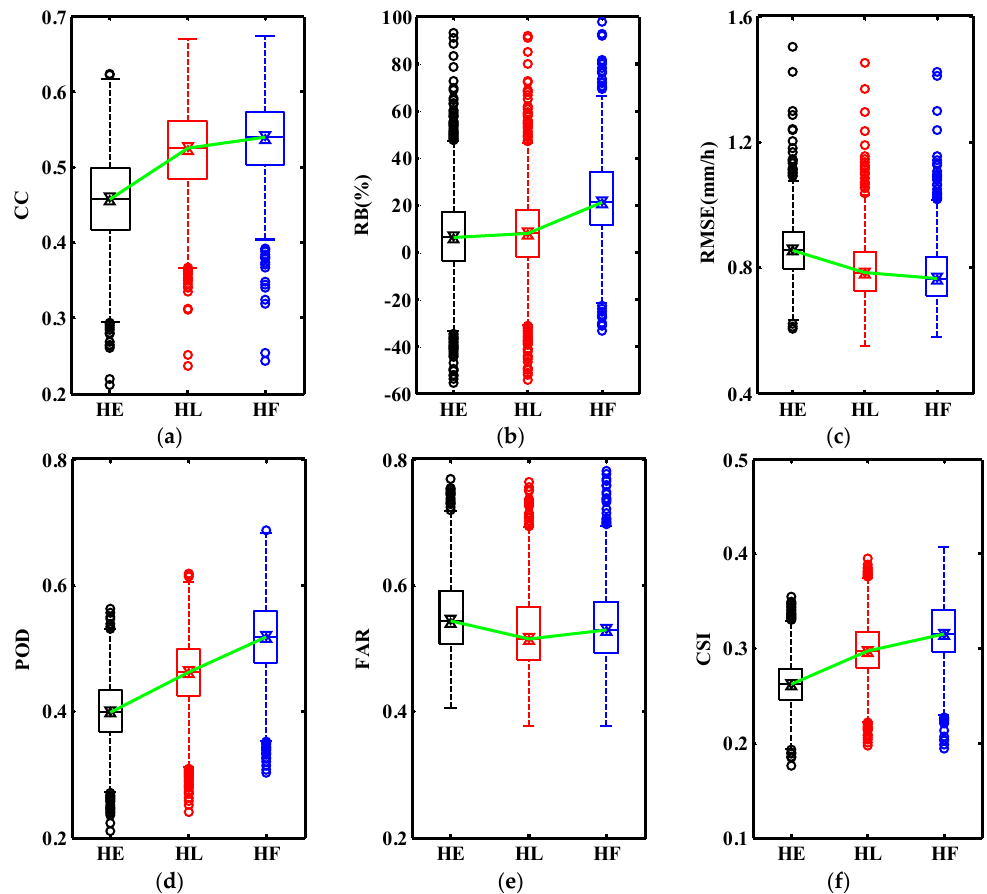
Figure 3. Box plots of the statistical metrics for the IMERG-HE, IMERG-HL, and IMERG-HF products: ( a – f ) CC, RB, RMSE, POD, FAR, and CSI, respectively.